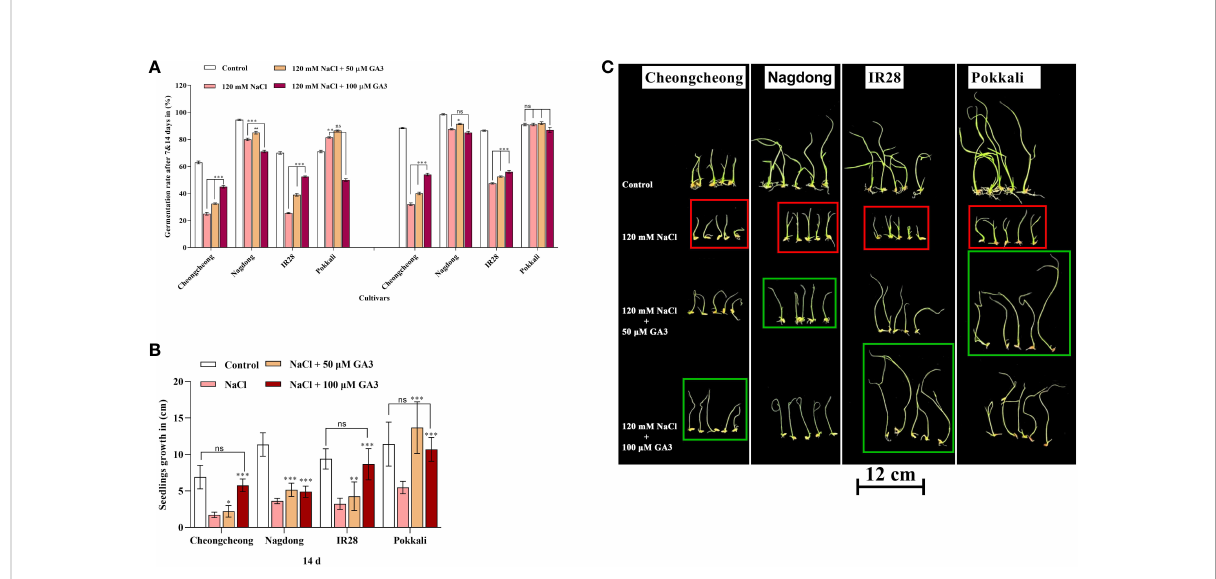
FIGURE 2 Effect of salt stress and exogenous GA3 application on seed germination in different rice ( Oryza sativa L.) cultivars are indicated in red, and green boxes. The effects of different concentrations of exogenous GA3 on seed germination (A) , seedling growth (B) , and seedling phenotypes (C) were evaluated in rice cultivars under salt stress. Group differences were analysed by two-way ANOVA. Asterisks indicate a signi fi cant difference compared to the control group, as analysed by Duncan ’ s multiple comparison test. * P < 0.05, ** P < 0.01, *** P < 0.00; ns, not signi fi cant. GA3, gibberellic